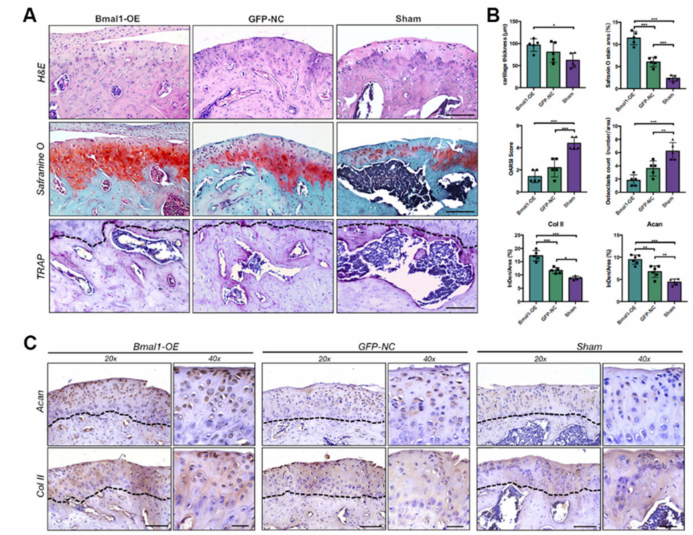
Figure 7. Transplantation of Bmal1 -OE BMSCs reversed age-related TMJ condylar cartilage degen- eration and subchondral bone loss. ( A ) H&E, Safranin O, and TRAP staining of sagittal sections of the Bmal1 -OE, GFP-NC, and Sham group TMJ condyles. Scale bar: 50 µ m. ( B ) Quantitative analyses of cartilage thickness, safranin O staining area, OARSI score in safranin O staining sec- tions and osteoclasts counts in TRAP staining sections; quantitative analyses of immunostaining for ACAN and COL II in TMJ condyles in different groups. ( n = 5–6) * p < 0.05, ** p < 0.01, *** p < 0.001. ( C ) Representative images of immunostaining for Acan and Col II in TMJ condyles in different groups. Scale bar: 75 µ m for 20 × and 25 µ m for 40 × . The black dotted lines indicated the osteochondral interface of TMJ